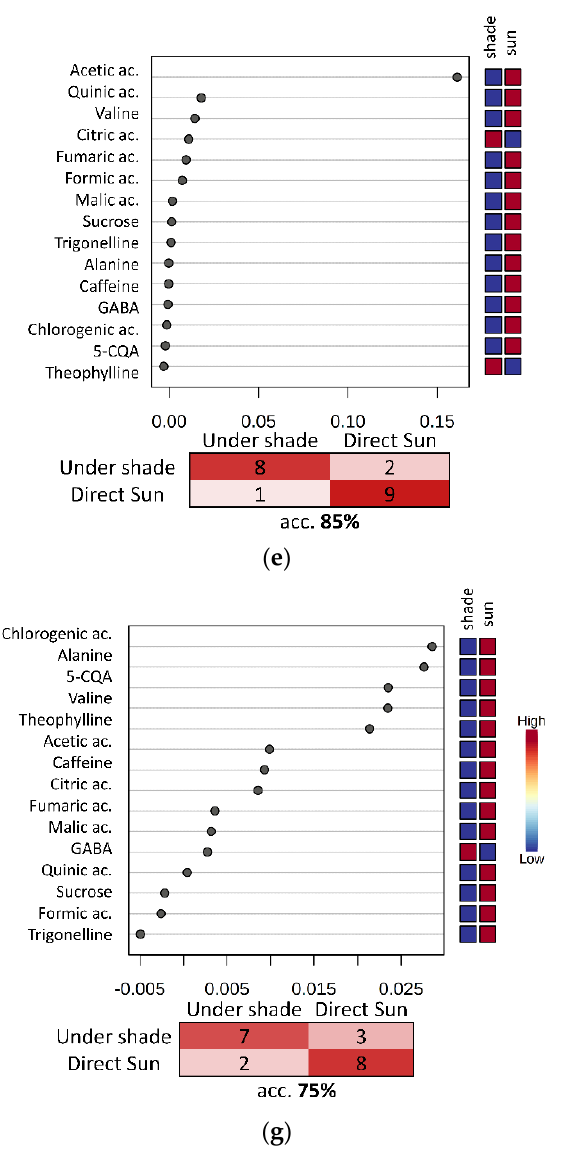
Figure 6. RF models on green coffee metabolites characterizing each variety according to the different drying procedures used: “under shade” and “direct sun”. ( a ) catuai rojo; ( b ) maracaturra; ( c ) bourbon; ( d ) caturra; ( e ) pacamara; ( f ) tekesic; ( g ) bourbon rojo. Mean decrease accuracy values are reported on the orthogonal axis of each plot.